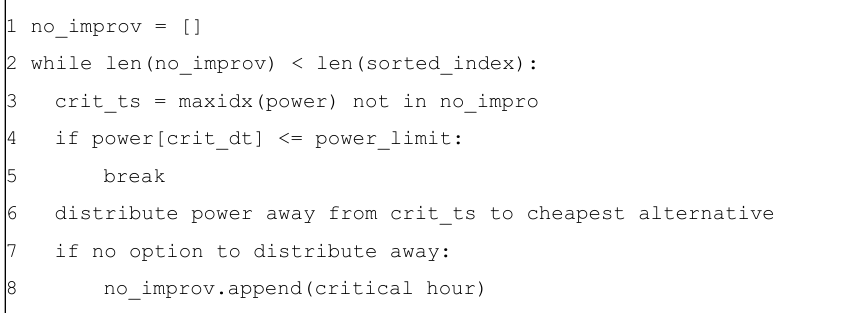
Figure A2. Peak power reduction pseudo code.